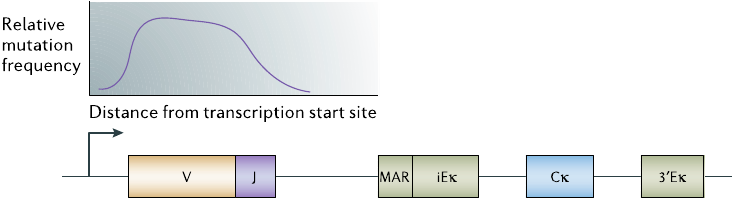
Figure 1. Schematic diagram of gene-specific targeted hyper-mutation in immunoglobulin gene loci. The mutation rate is greatly increased only in the variable part of the genome, which is a ~1.5 kilobase region in each of the three immunoglobulin loci. In this figure, the rectangular elements (V, J, MAR, iE κ , C κ , 3 ′ E κ ) represent different functional parts of the DNA sequence for the immunoglobulin protein. V is the variable part, subject to hypermutation, while the other parts are fixed. For further details on the functions of the parts see Odegard and Schatz [22]. Those details are not important for the purposes of this article.